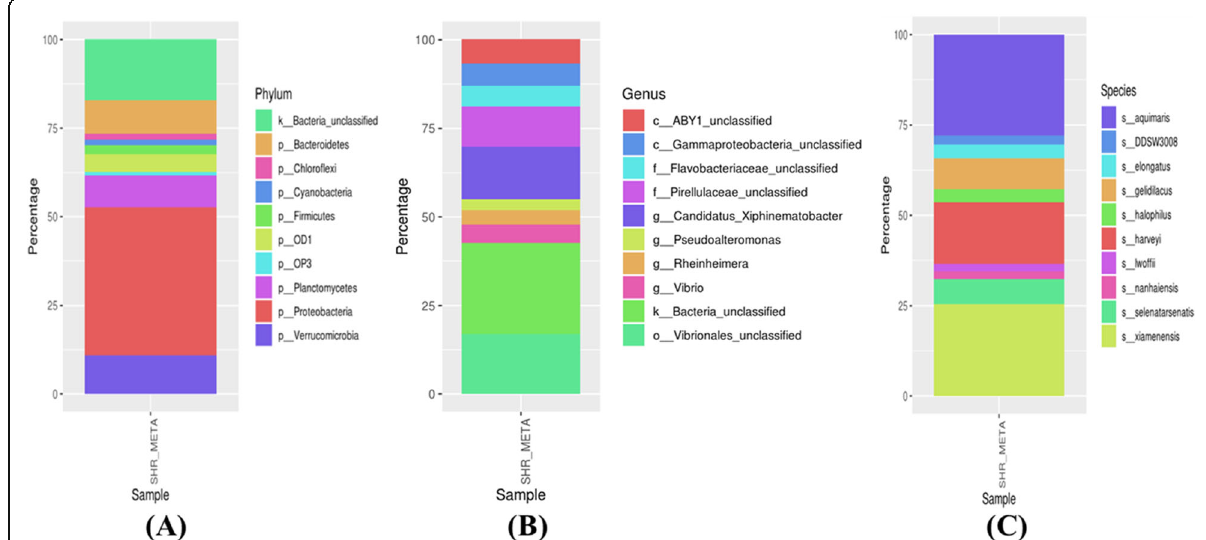
Fig. 1 Diversity of microbial community identified using 16S rRNA gene-based high-throughput sequencing of the shrimp culture system. ( A ) Top 10 microbial community structure at the phylum level. ( B ) Top 10 microbial community structure at the genus level. ( C ) Top 10 microbial community structure at the species